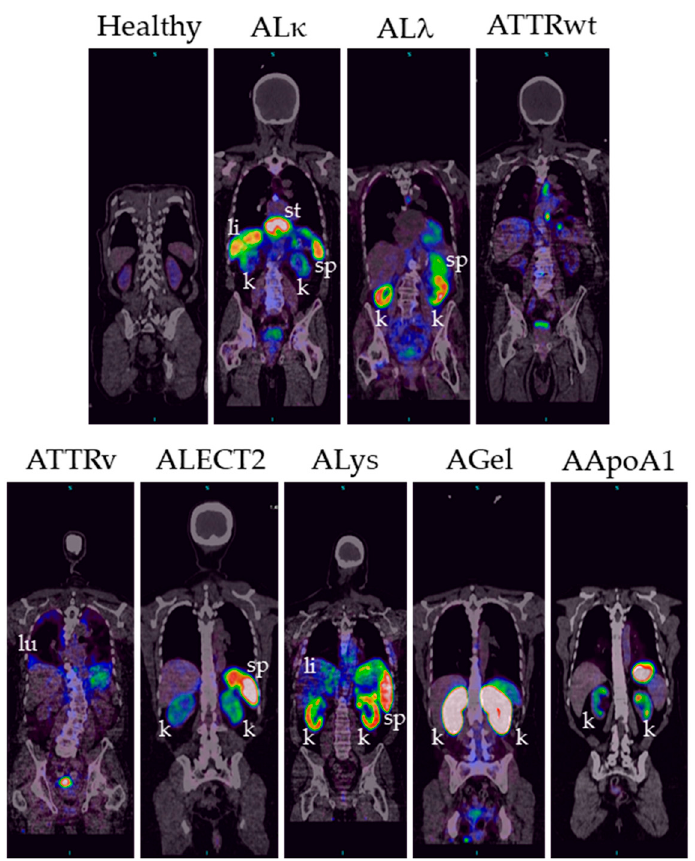
Figure 5. Coronal PET/CT images of a representative healthy subject and patients showing specific and heterogenous uptake of radiotracer in abdominothoracic organs. Images have been scaled as described in Figure 3.